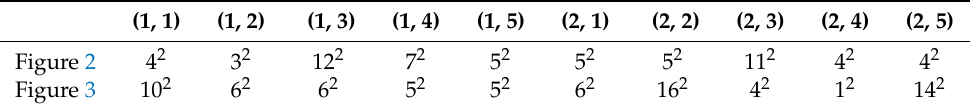
Table 3. The value of λ in the proposed PPA–CS method when it obtained our segmentation results in Figures 2 and 3, where the notation ( i , j ) corresponds to the image shown in Figure 2 (resp. Figure